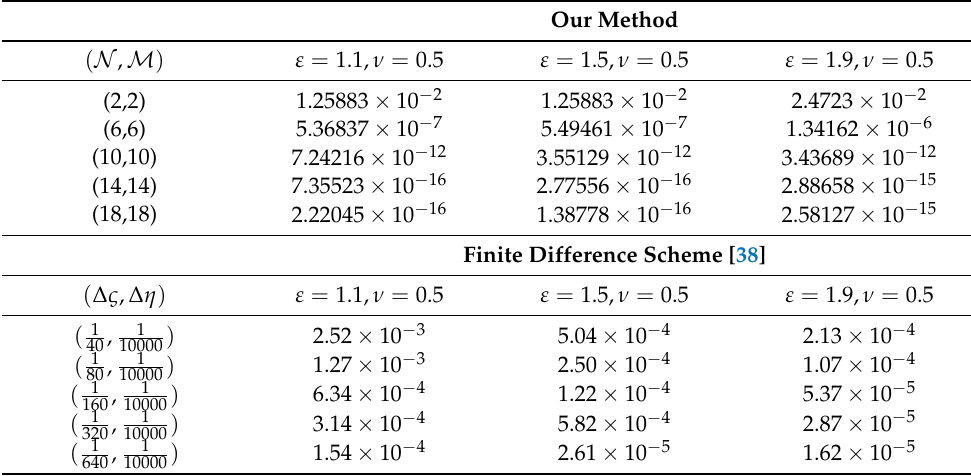
Table 2. MAEs for problem